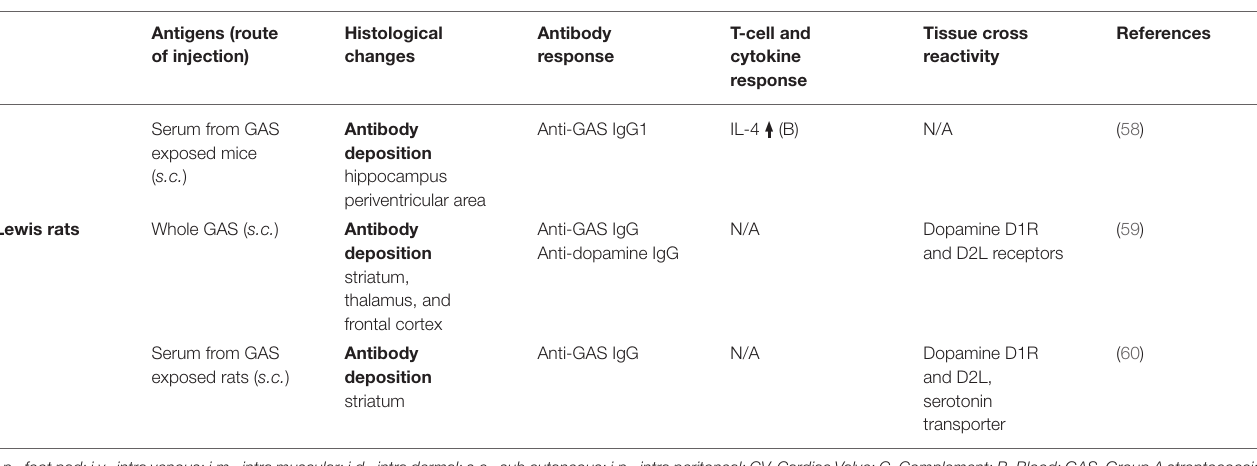
associated regulators observed in the pathological process may (49, 50). In a separate experiment, in response to